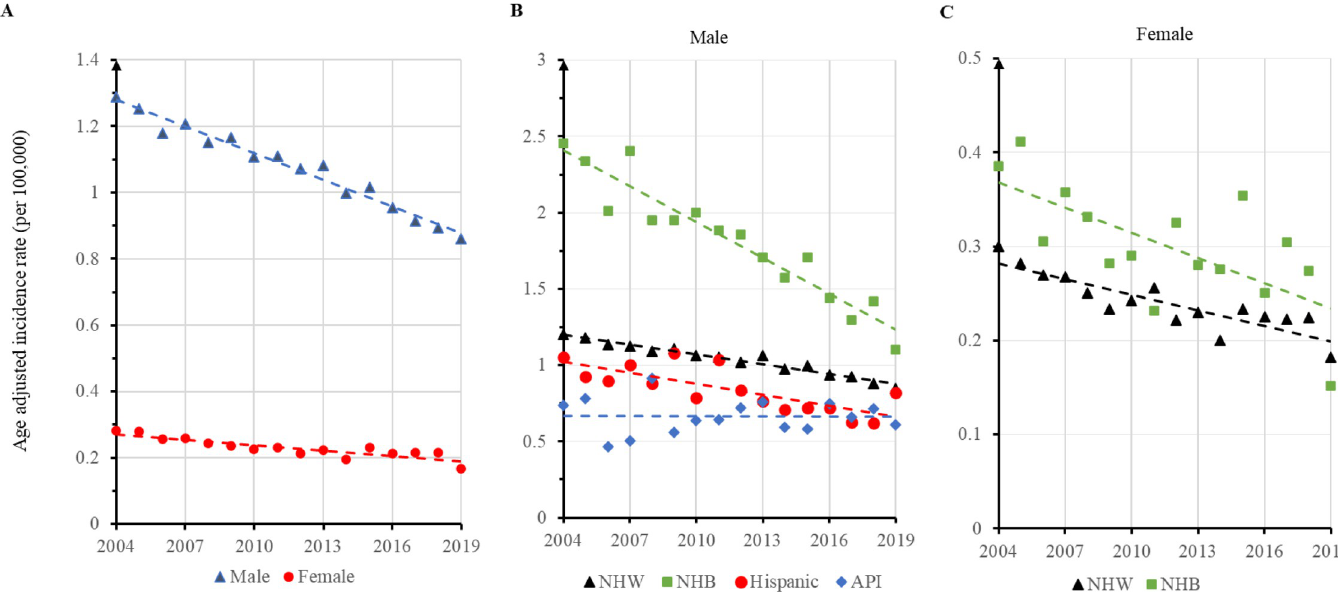
Fig 1. Age adjusted incidence rate (AAIR) of hypopharyngeal squamous cell carcinoma (HPSCC) by sex and race during 2004–2009. ( A ). Temporal change of overall AAIR in males and females. ( B ). Trends of AAIR in male non-Hispanic white (NHW), non-Hispanic black (NHB), Hispanic and Asian or Pacific Islanders (API). The lines indicate temporal trends. Data of female Hispanic and API were not available in many individual years and not